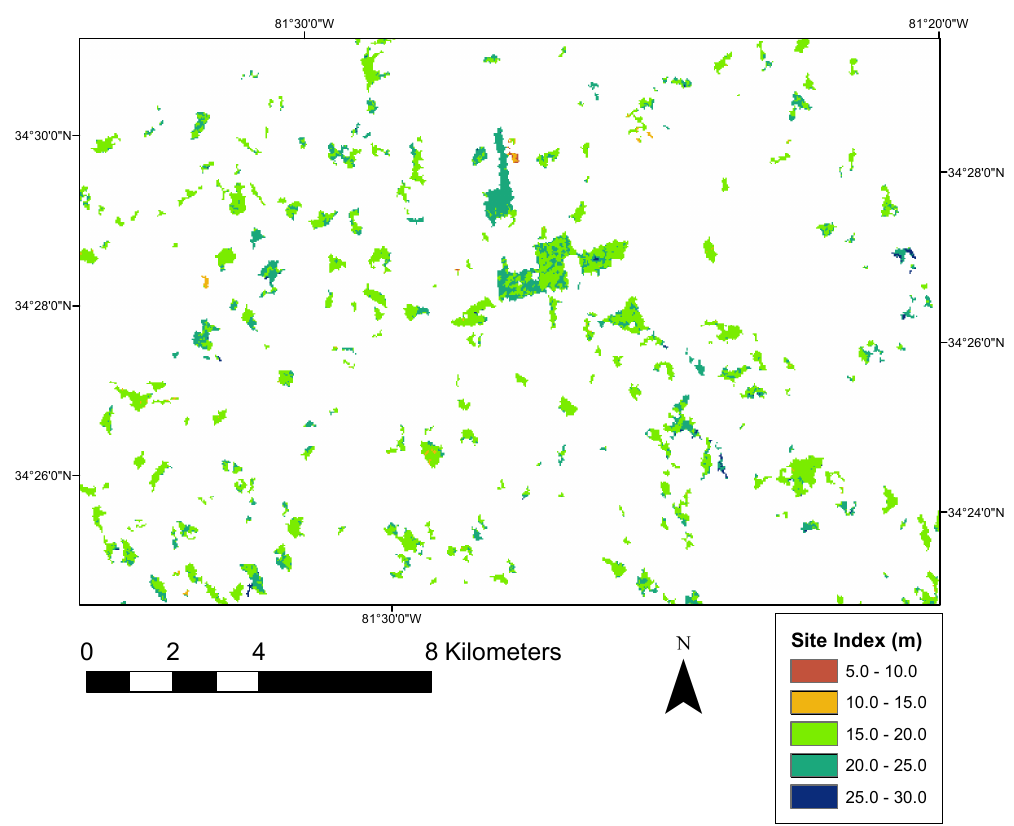
Figure 7. A part of the site index map generated is shown here at a scale where forest stands are visible (Newberry County, South Carolina). A very small percent of pixels (less than 0.1%) where site index values more than 30.0 m were predicted are not shown (as they were mostly model over-predictions). Most stands register reasonable to good site index values (e.g., greater than 20.0 m) while some under-perform (less than 10.0). However, the fairly large error in SI (RMSE of 3.0) should be kept in mind when performing such analysis at the individual pixel